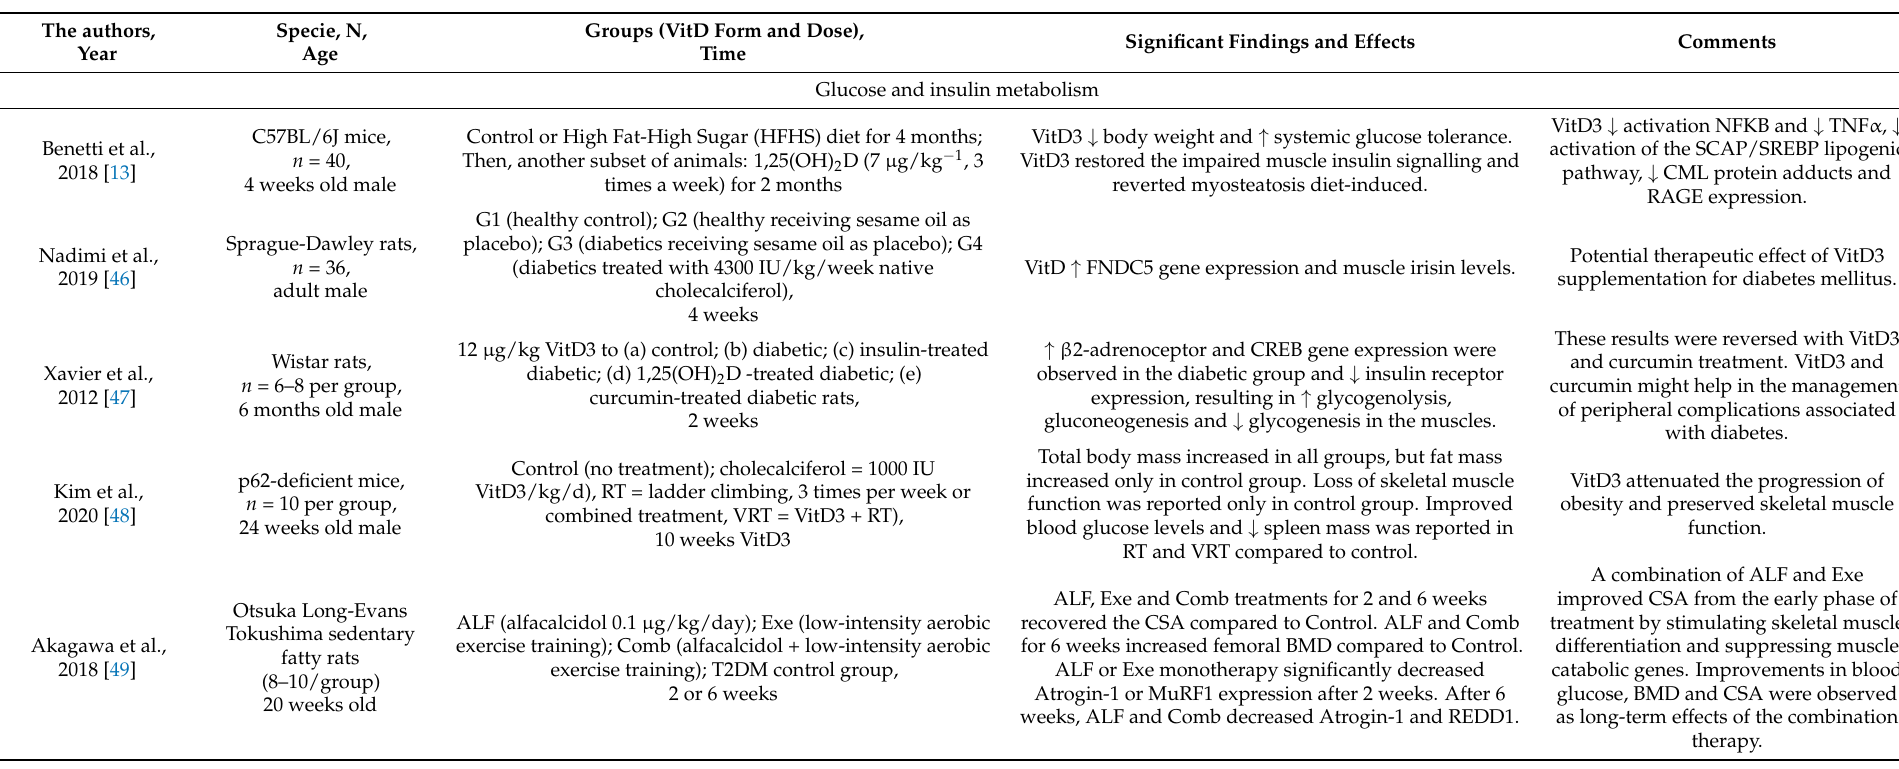
reverted myosteatosis diet-induced.